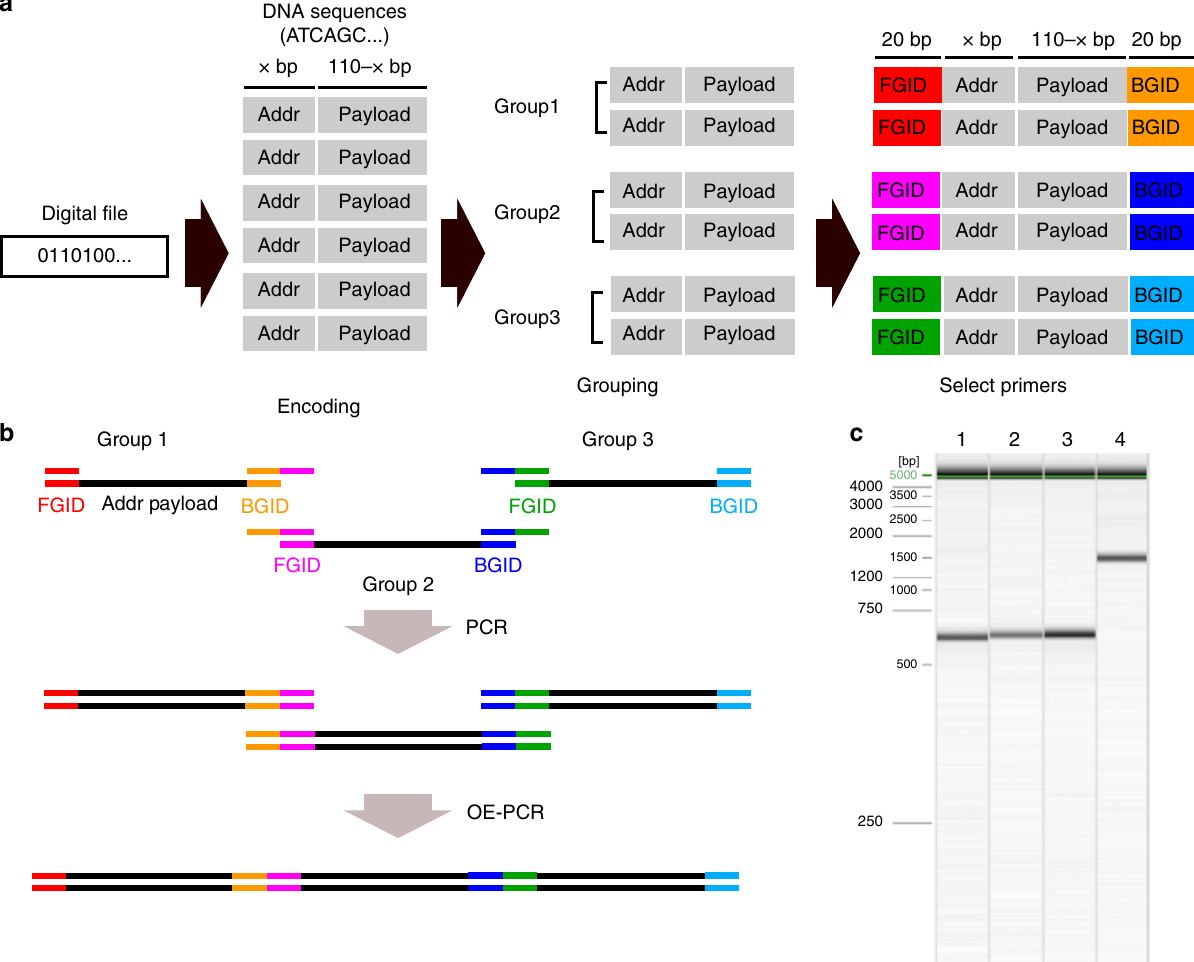
Fig. 3 Random access and OE-PCR strategy for DNA storage a First, a digital fi le is encoded using Reed – Solomon code to increase robustness to errors. The binary data then get broken into fi xed-size payloads and mapped to 110-bp DNA nucleotides with addressing information (Addr). These DNA fragments are split into multiple groups, each group is given unique primers as group ID (FGID front group ID, BGID back group ID). b To retrieve a particular fi le, each group is ampli fi ed with primers containing overhangs overlapping with each adjacent group primers. Subsequently, all the groups can be combined and ampli fi ed using primers corresponding to the end (e.g., FGID in the group 1 and BGID in the group 3) to form the assembly product using